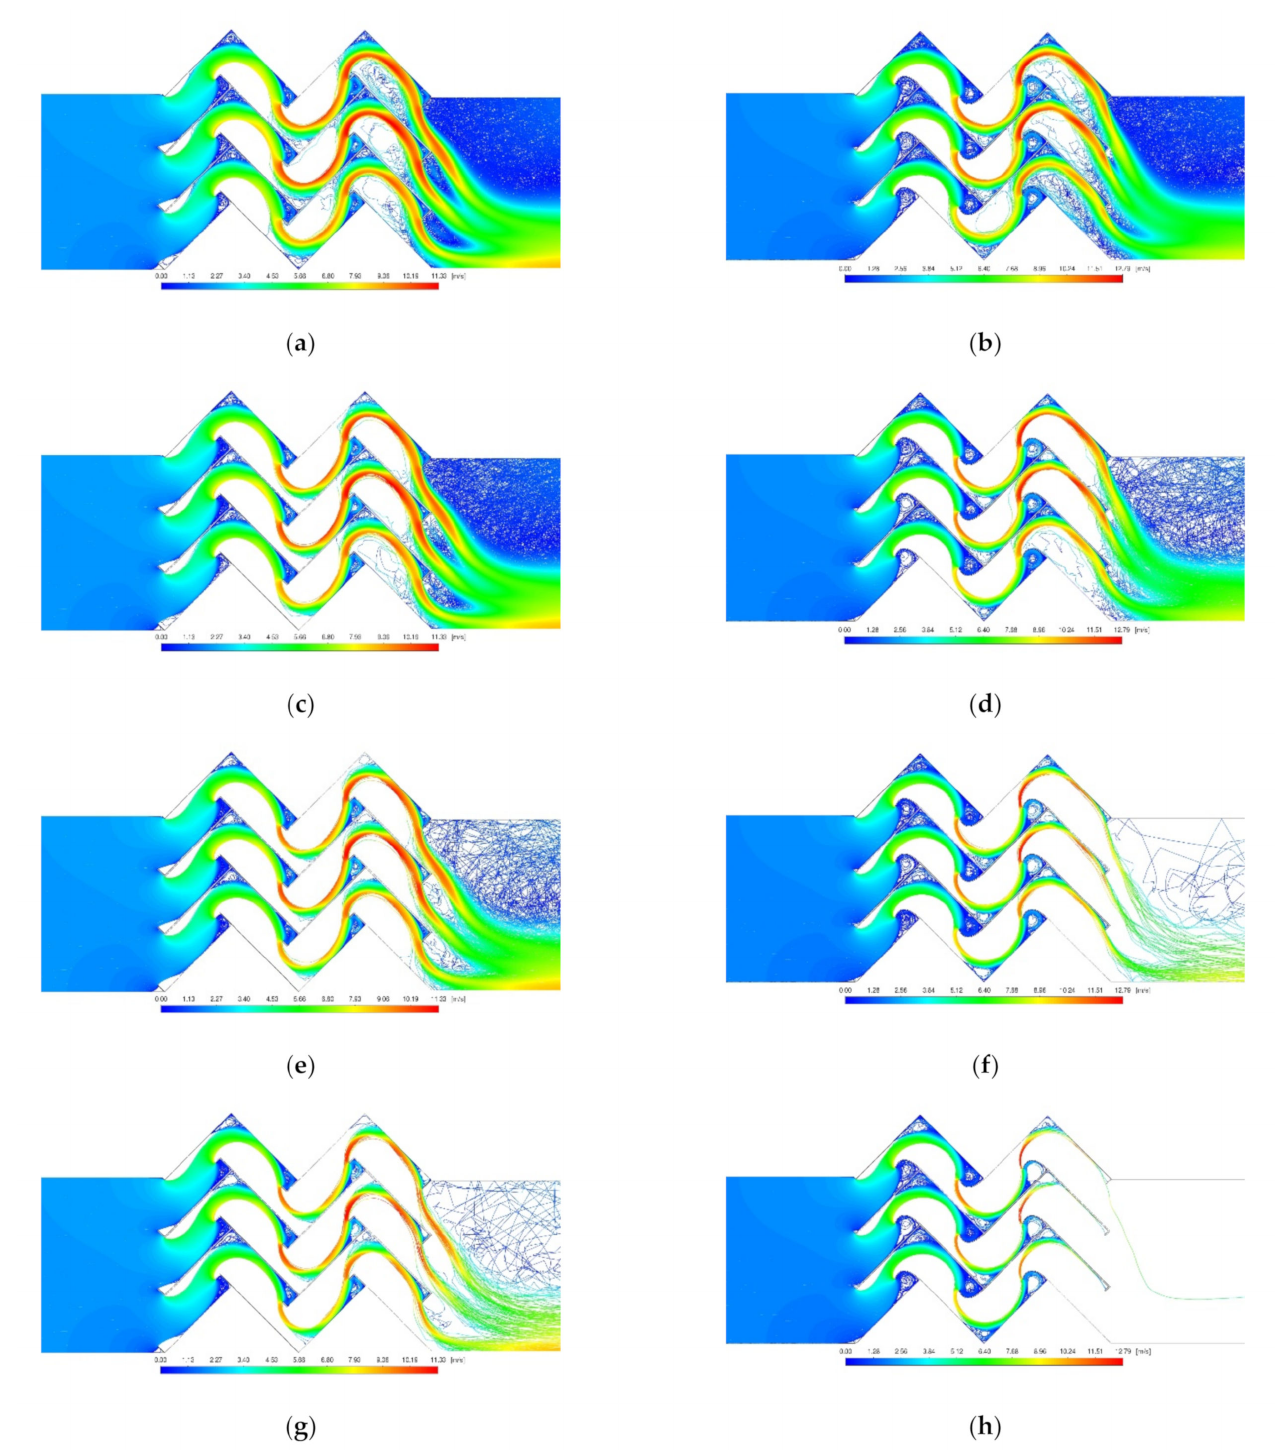
Figure 21. Droplet trajectories for geometries B_15_0 ( a , c , e , g ) and C_15_0 ( b , d , f , h ) for velocity 2 (m s − 1 ) and droplet diameters: 8 ( µ m) ( a , b ); 10 ( µ m) ( c , d ); 12 ( µ m) ( e , f ); 14 ( µ m) ( g , h